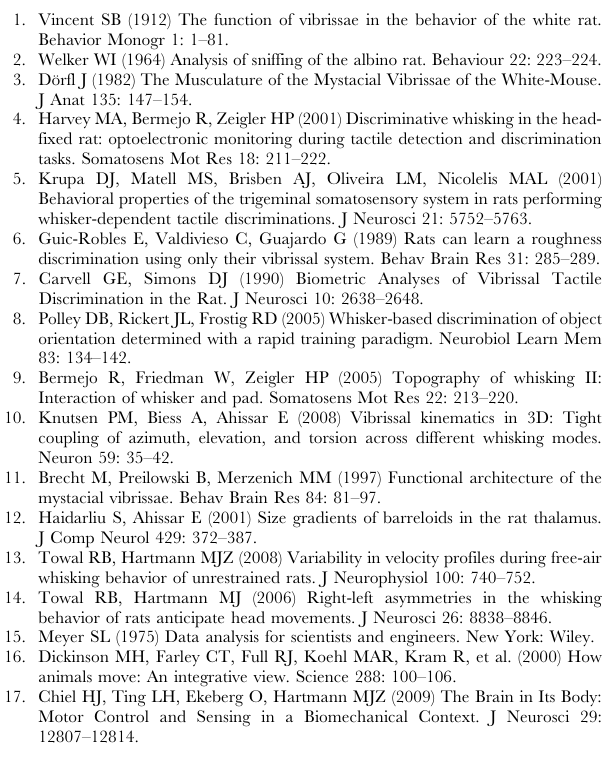
Table S1 Cesa`ro notation and interpretation of different coefficient combinations.